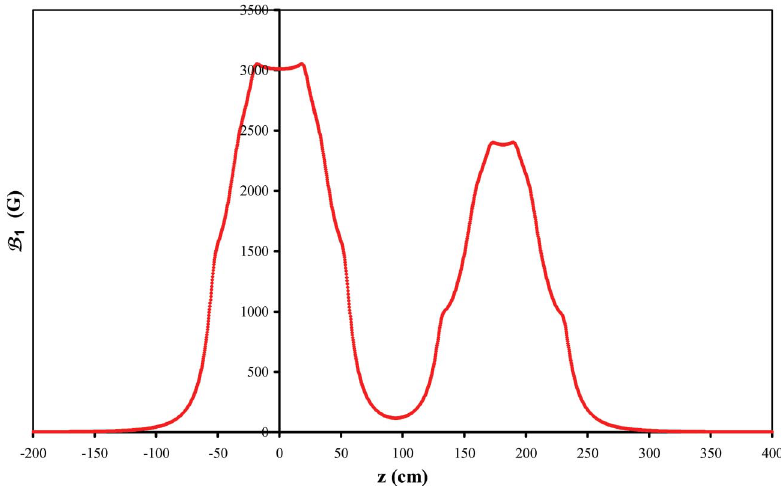
FIG. 5. (Color) Dominant component B